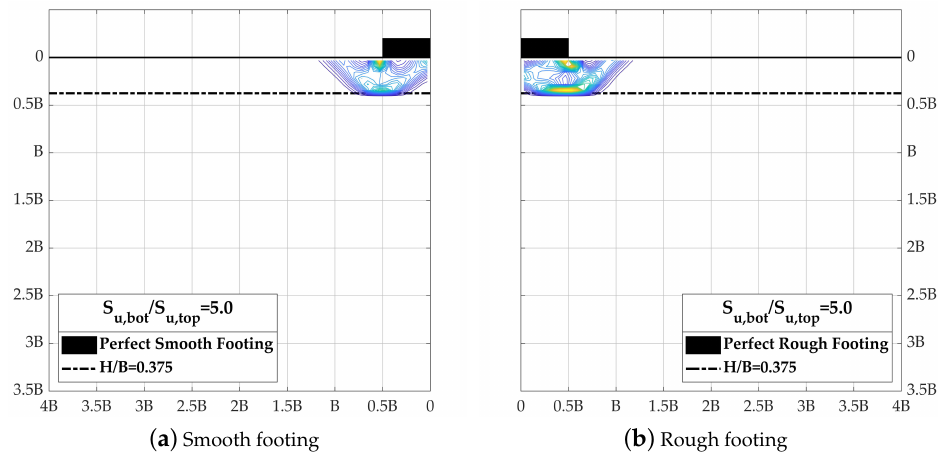
Figure 18. Maximum shear strain rate at the numerical limit load ( H / B = 0.375, S u , bot / S u , top = 5.0).